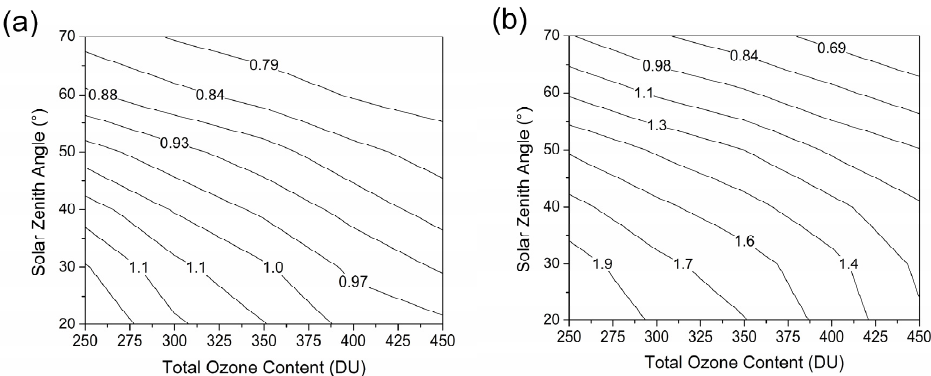
Figure 4. Examples for correction factors (calibration matrix) for polysulphone film (PSF) to gain erythemally effective radiant exposure (panel ( a )) or vitamin D effective radiant exposure (panel ( b )) (after